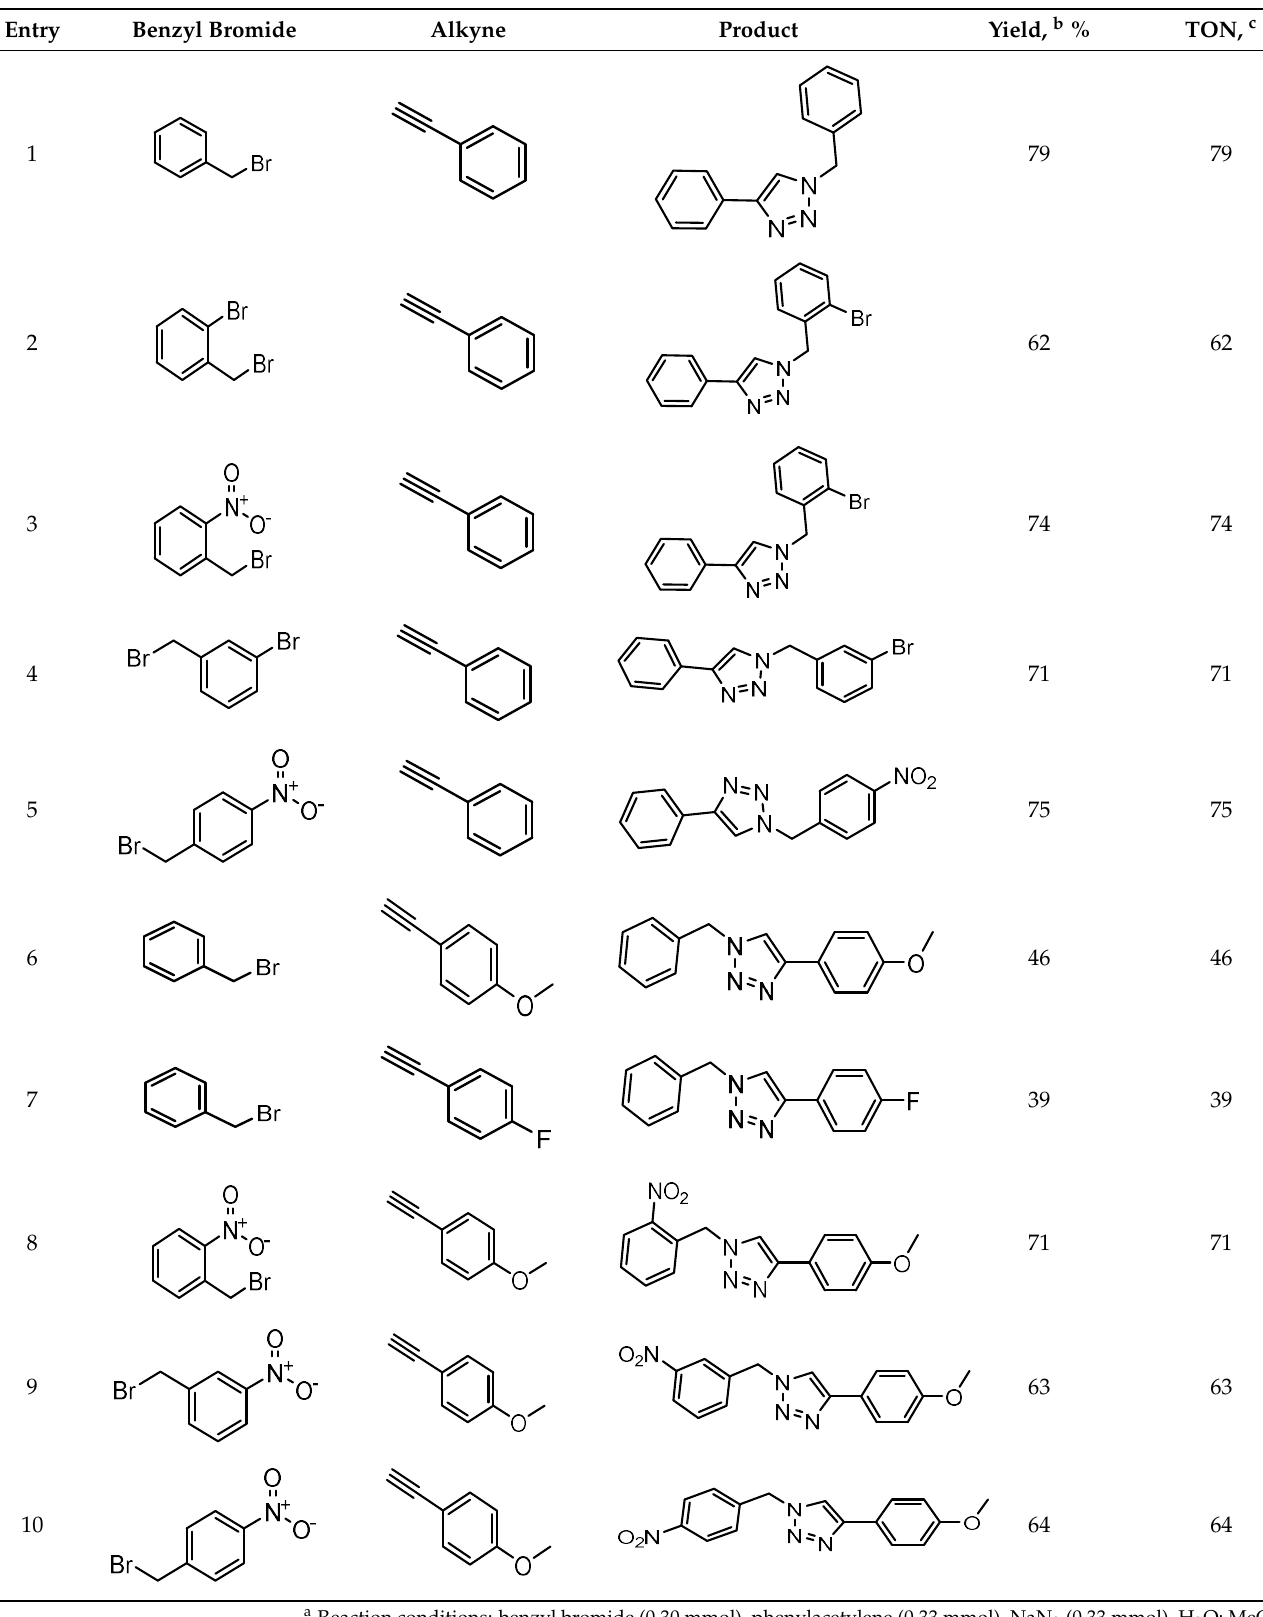
mmol), H 2 O: MeCN (0.5 mL, 1:1 v / v ), MW (30 W, 150 °C), 15 min, 1.0 mol% of Au catalysts vs. zyl bromide derivatives. b Isolated yield. c Turnover number = moles of product per mol of cata- lyst. lyst.